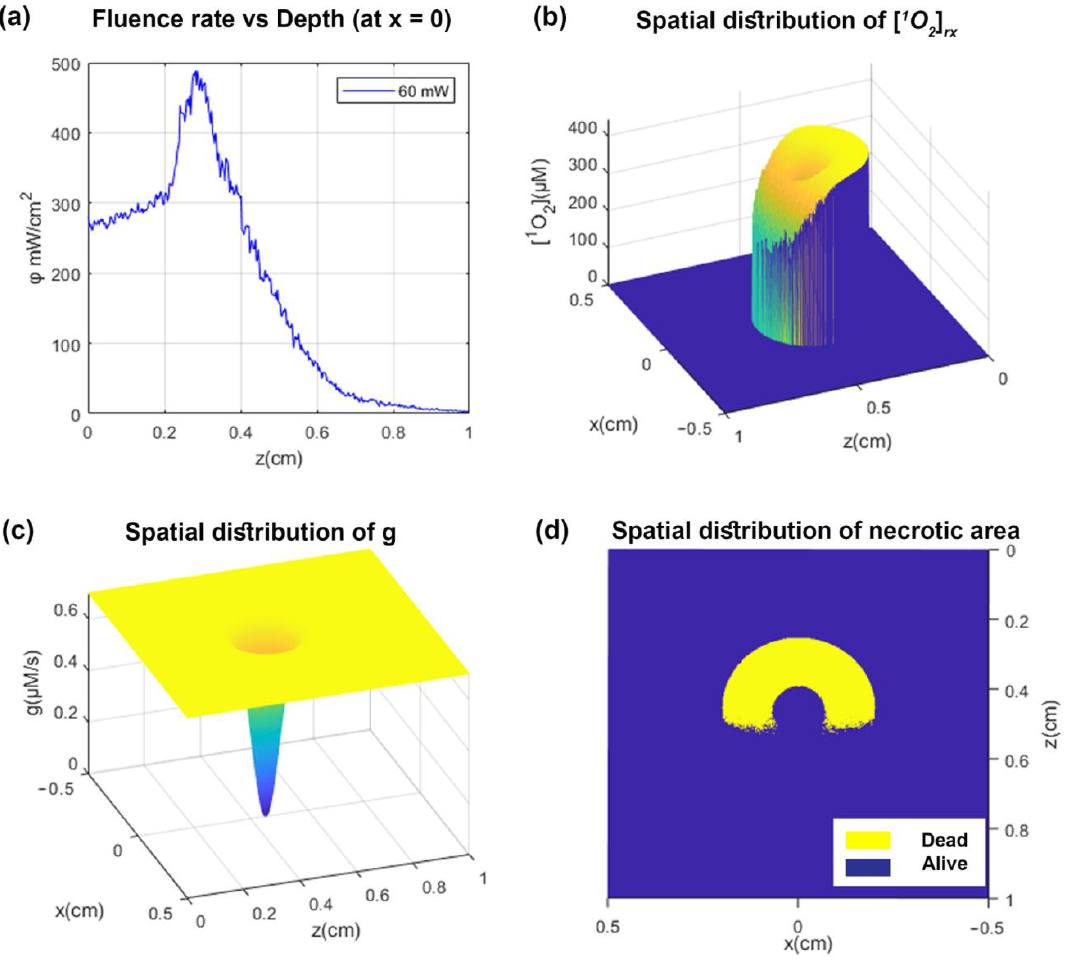
Figure 3. Results of the PDT simulation for 13.369.517 photons. ( a ) Fluence rate at z axis, at x = 0. ( b ) Spatial distribution of the of produced [ 1 O 2 ] rx . ( c ) Spatial distribution of the oxygen supply rate, in order to simulate the oxygen perfusion in the tumor. ( d ) Spatial distribution of the necrotic tumor area.